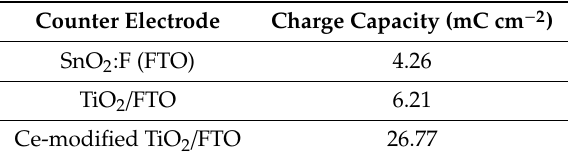
Table 1. Comparison of charge capacity of the measured films.